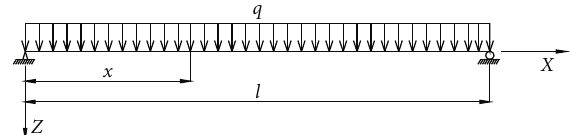
Figure 6: Schematic representation of a simply supported com- posite box girder with CSWSB under uniformly distributed load condition.